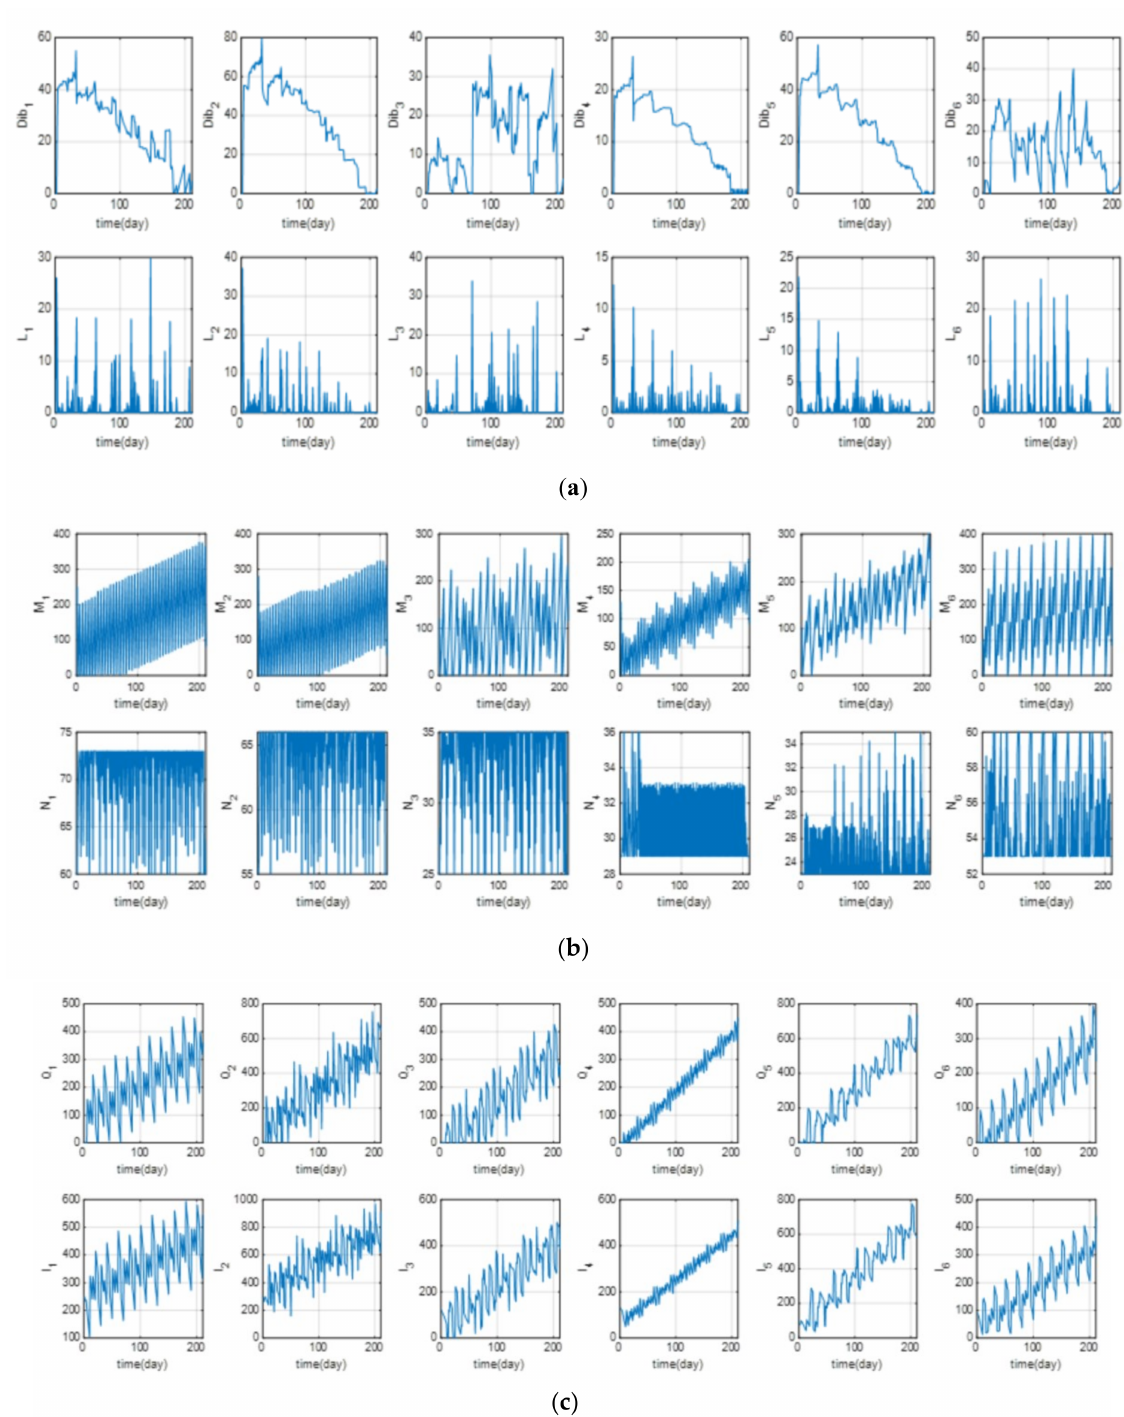
Figure 2. Results of simulation for Topology 1: ( a ) the results of simulated debt value to the bank (first row) and bank financing (second row) for each entity, ( b ) the results of simulated inventory level (first row) and production values (second row) for each entity, and ( c ) the results of simulated profit value (first row) and working capital (second row) for each